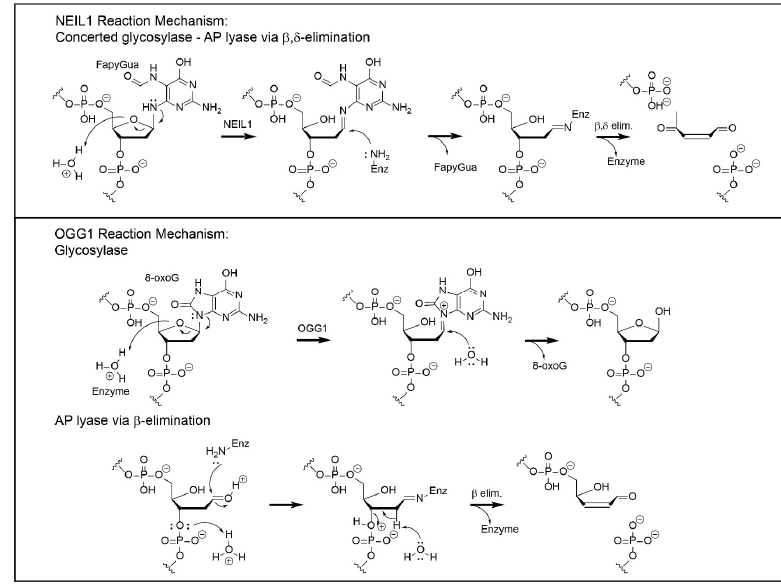
Figure 2. Chemistry of the mechanisms of NEIL1 and OGG1.